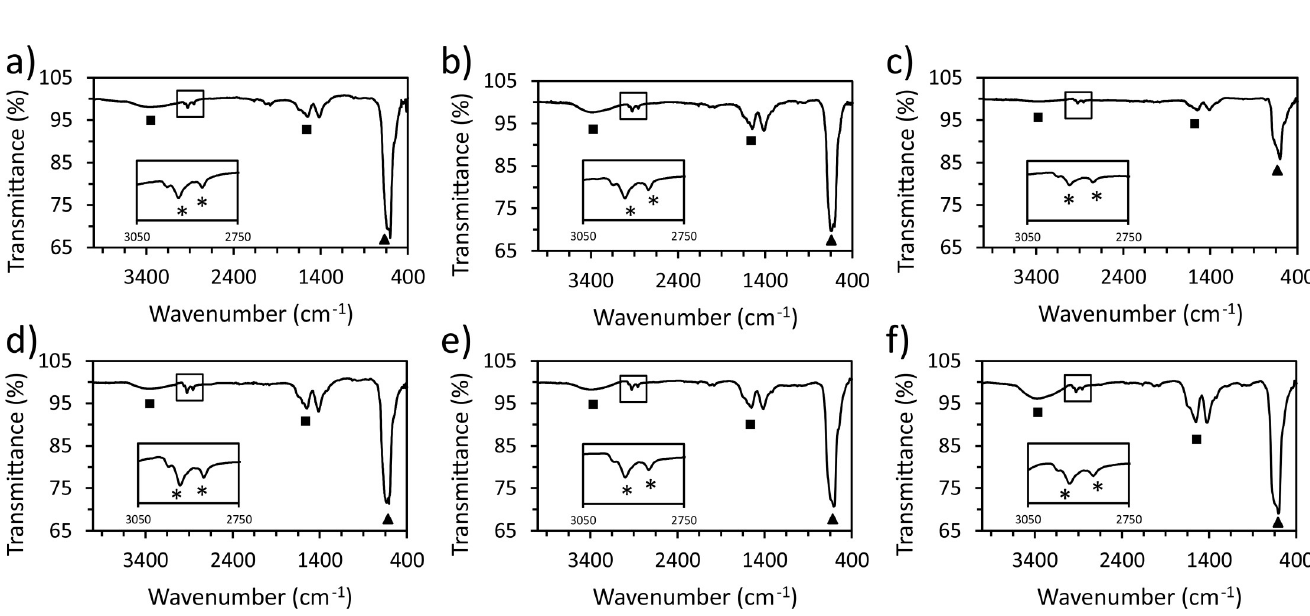
Fig 6. FTIR spectra of the following temperature profiles: 20˚C/min ramp with a) 5 min at 300˚C, b) 15 min at 300˚C, c) 30 min at 300˚C, and 10˚C/min ramp with d) 5 min at 300˚C, e) 15 min at 300˚C, and f) 30 min at 300˚C. Asterisks represent oleyl groups, squares correspond to amine groups, and triangles show the vibration of Mn-O and Mn-O-Mn bonds. The oleyl group spectral regions are enlarged in the boxed insets to resolve the two distinct peaks.